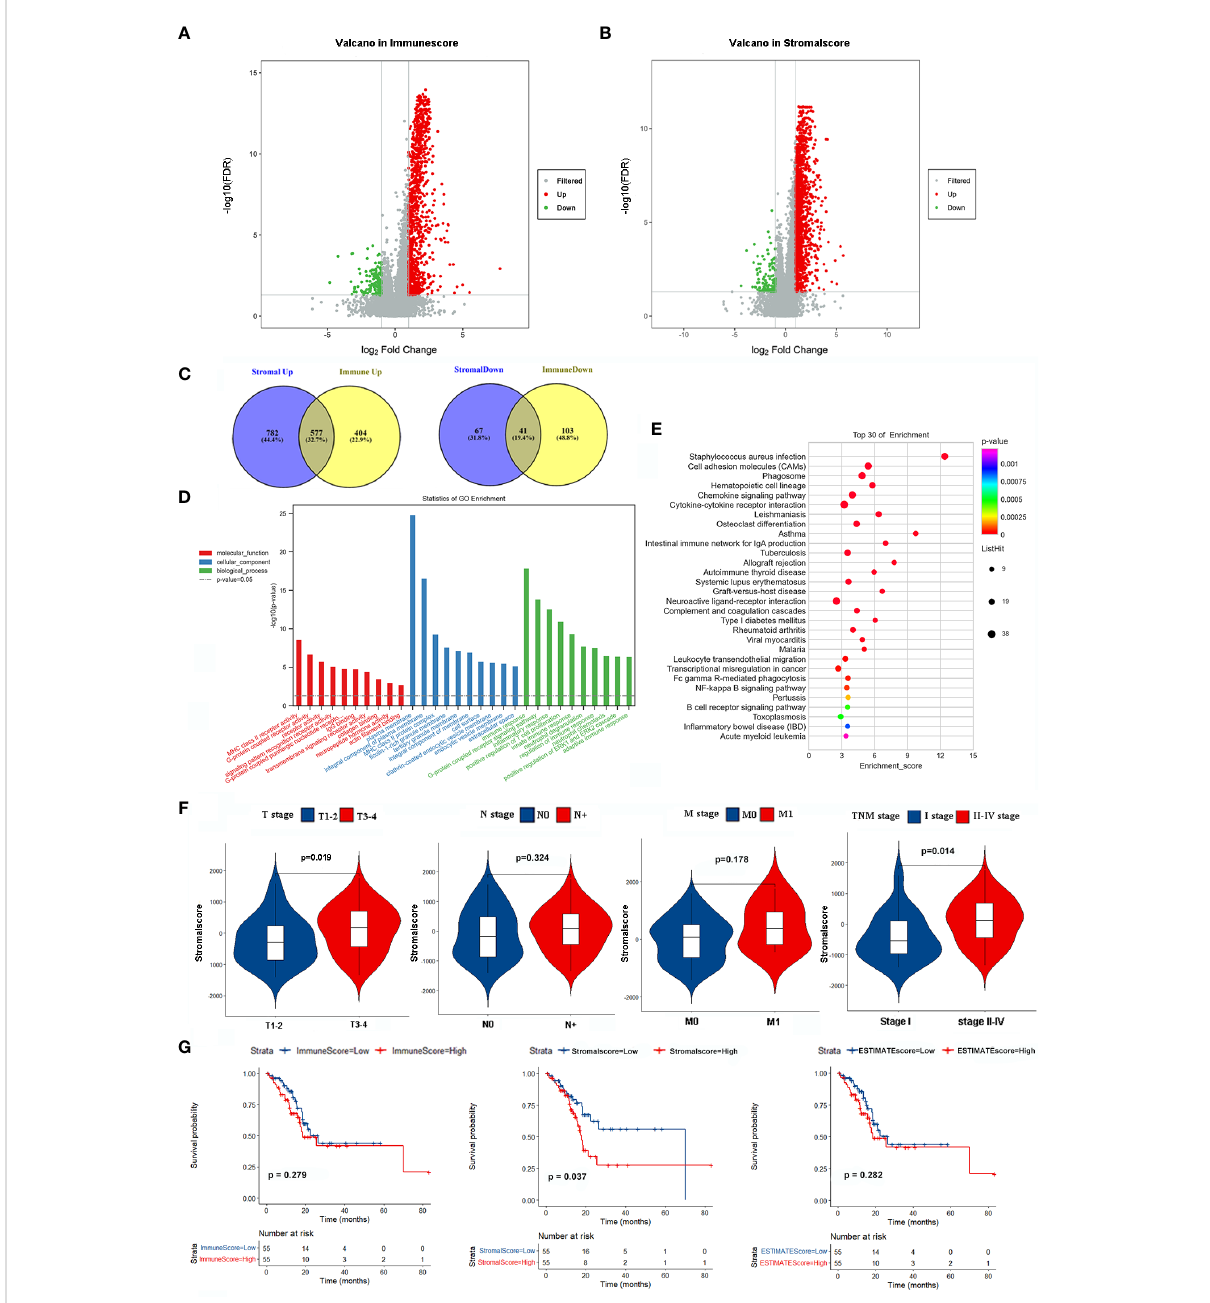
FIGURE 1 Identi fi cation SIRGs and enrichment analyses. (A) Volcano plot of DEGs in immunescore; (B) Volcano plot of DEGs in stromalscore; (C) Venn plot to identify SIRGs; (D) GO enrichment analysis; (E) KEGG pathway enrichment analysis; (F) The relationship between stromalscore and TNM stage; (G) Kaplan-Meier analysis in different